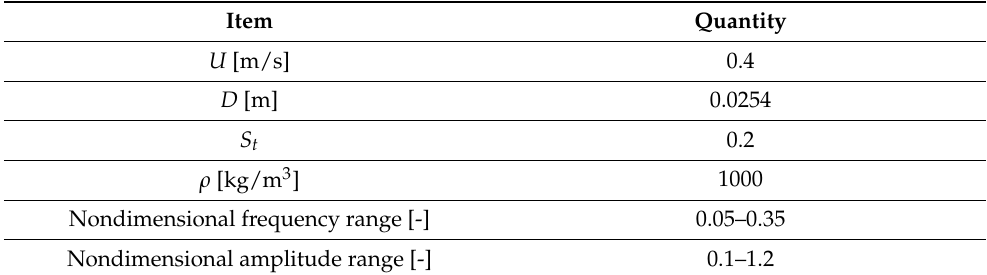
Table 2. Simulation parameters, forced oscillations